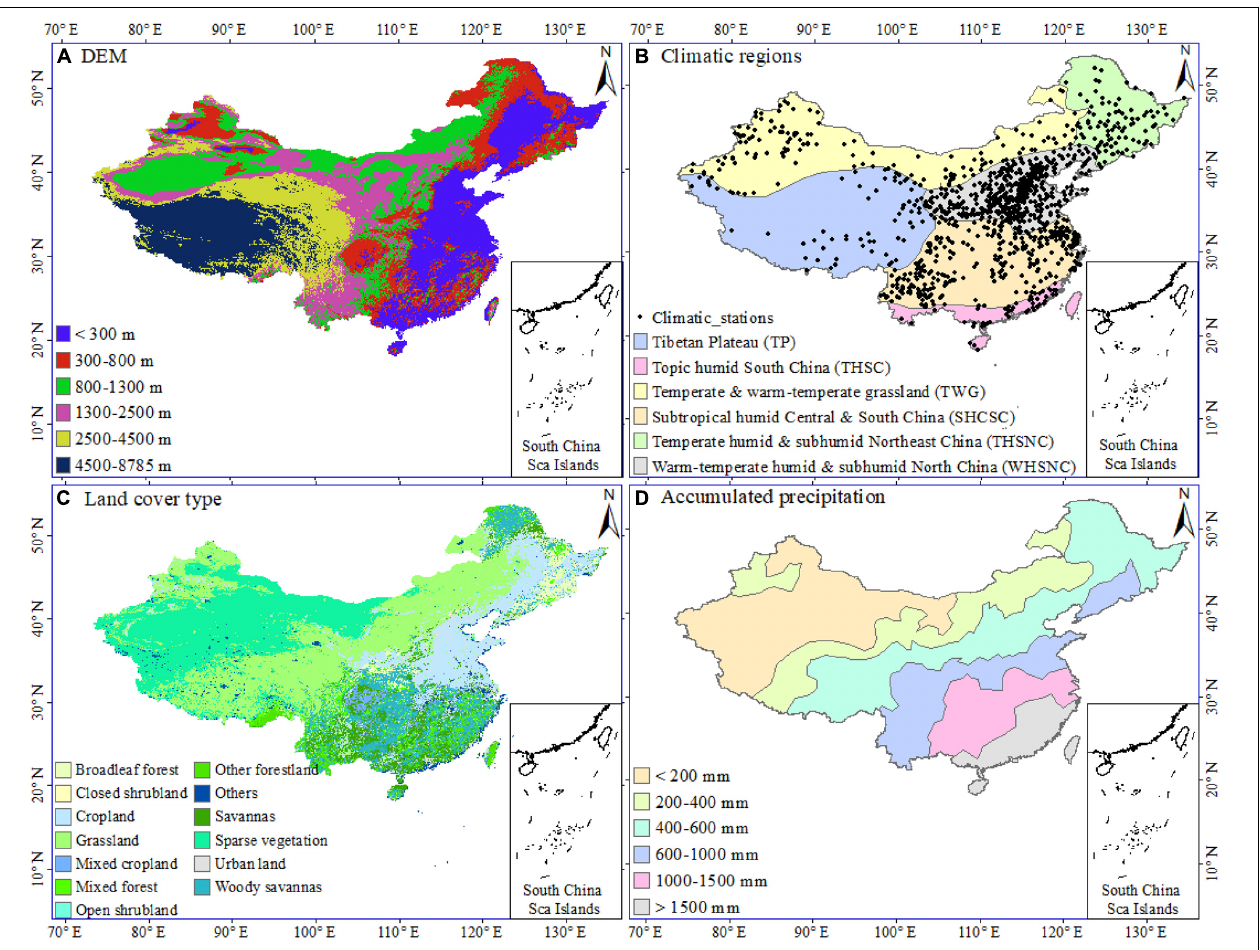
FIGURE 1 | (A) Digital elevation model (DEM), (B) geographic distribution of selected meteorological stations and natural climatic regions, (C) land cover types, and (D) accumulated precipitation in